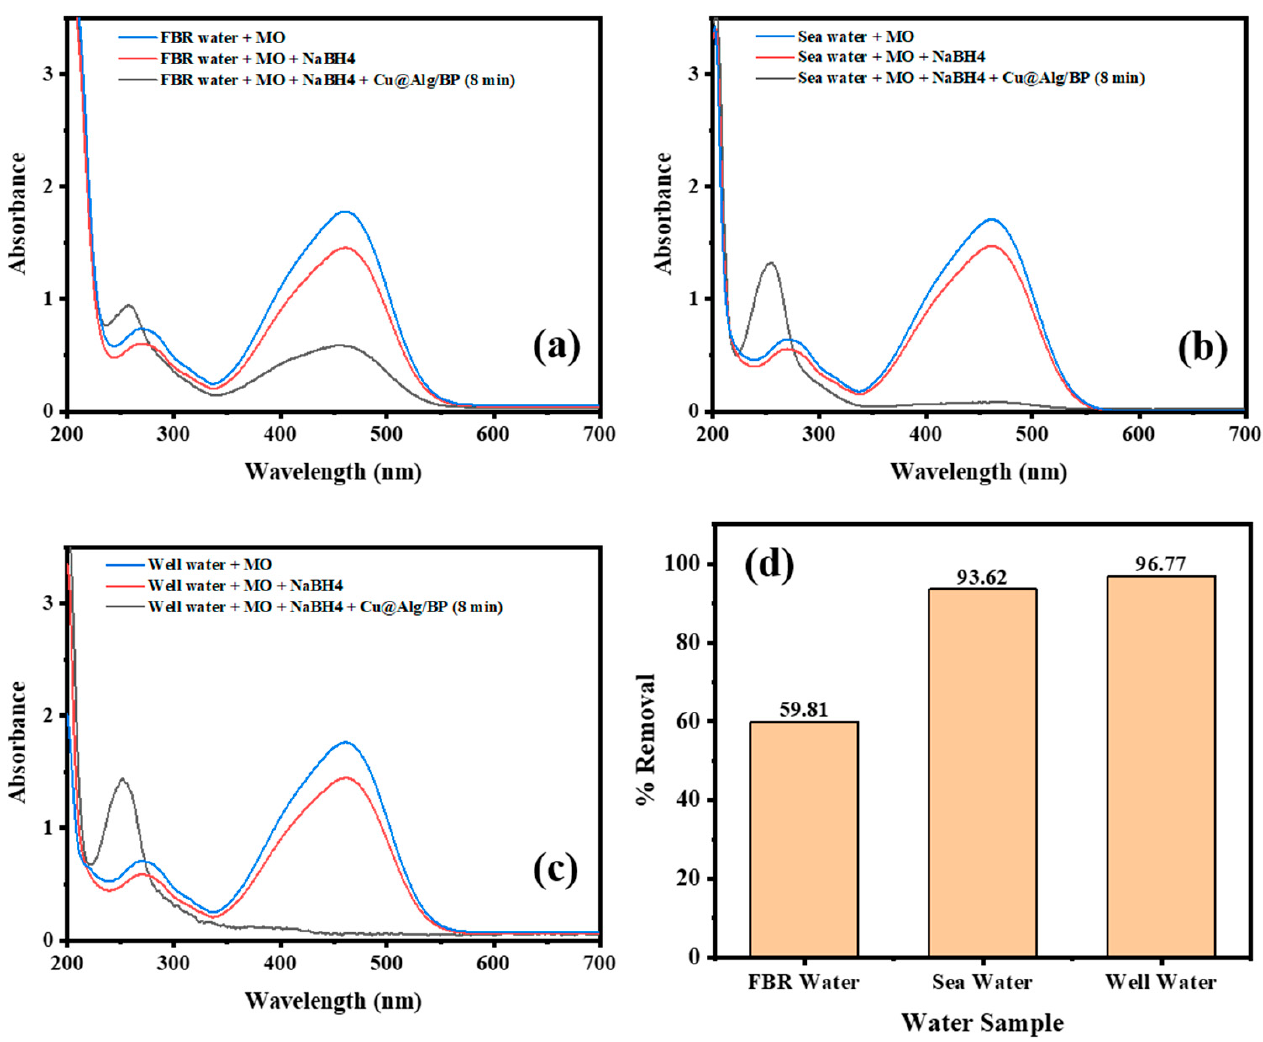
Figure 10. Time-dependent UV–Vis spectra for MO reduction by NaBH 4 using 3 beads of Cu@Alg/BP nanocatalyst in ( a ) FBR water; ( b ) sea water; and ( c ) well water. ( d ) Catalytic reduction of MO in real samples after 8.0 min contact time.